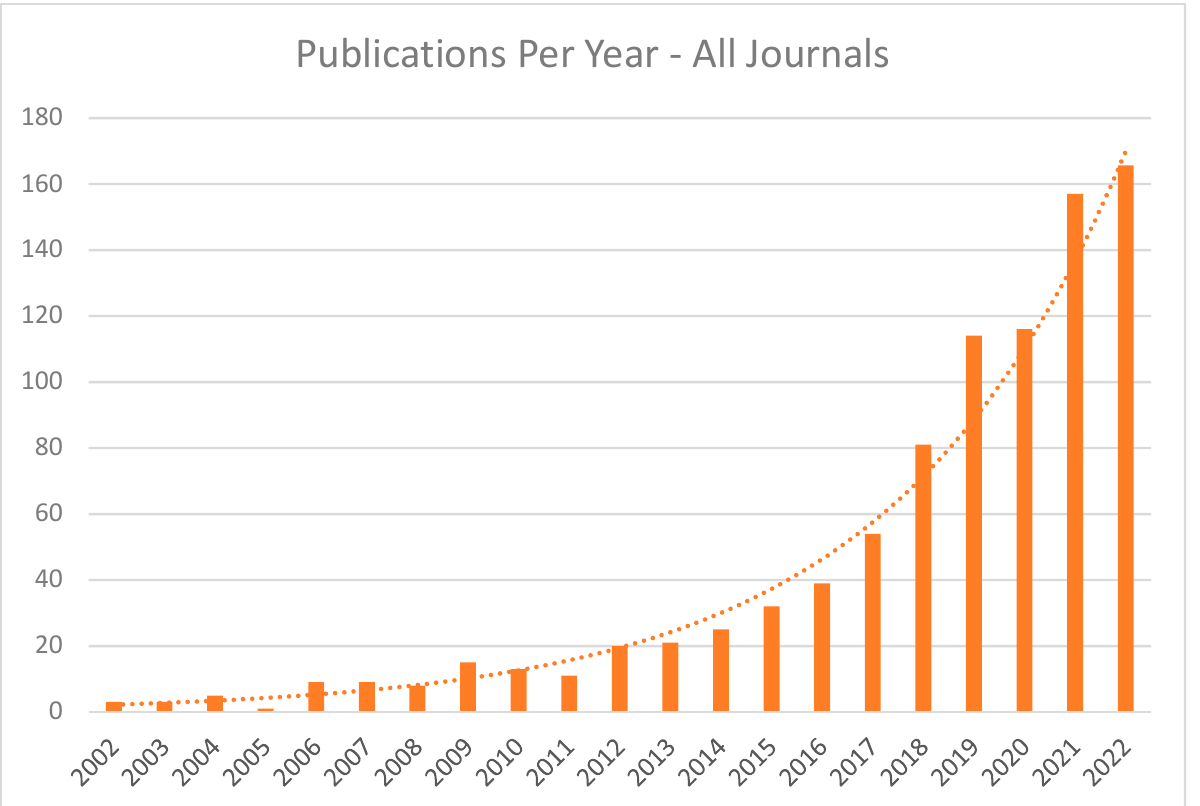
Figure 1. Publication per year, all journals. Figure 1.